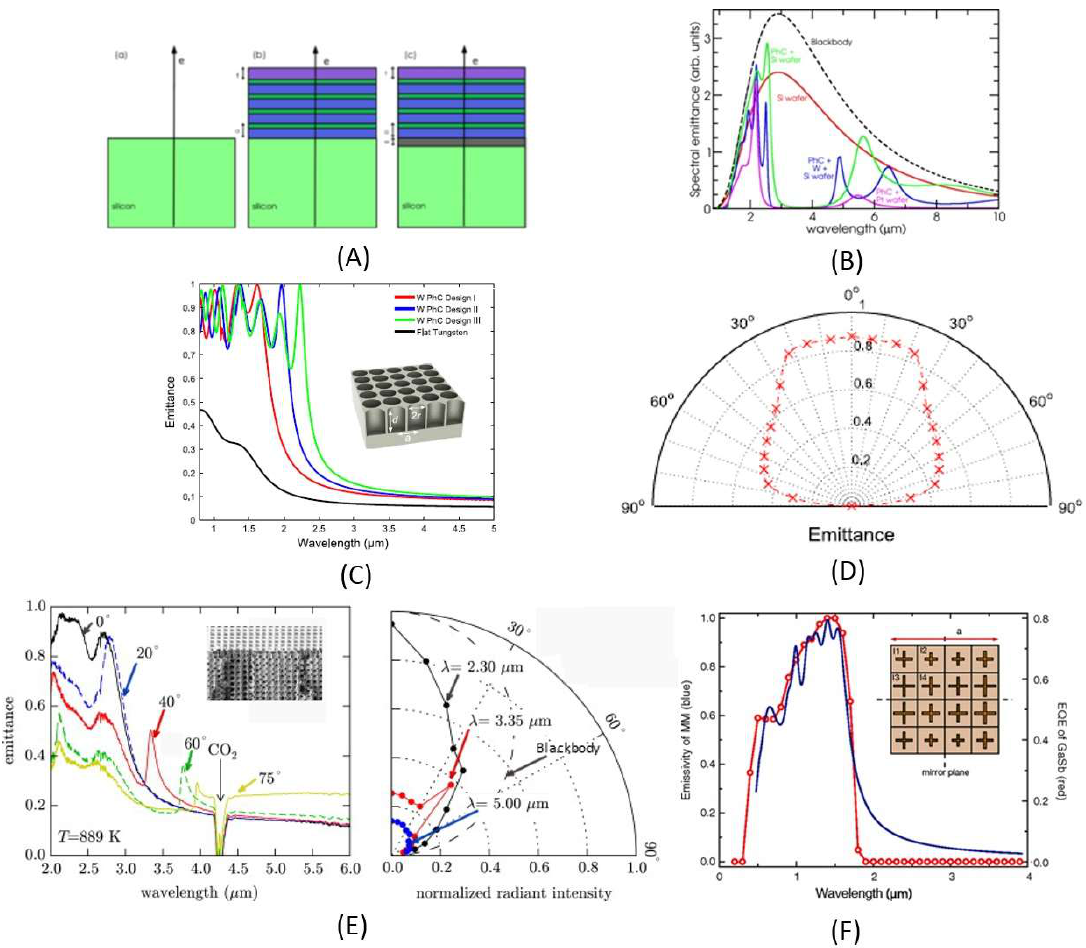
Fig. 8. Photonic crystal and metamaterial emitters. (A) Example of 1D Si/SiO 2 PhC, where an optimized number of layers exhibits the spec- tral emissivity shown in (B). Panels (A) and (B) adapted with permission from [50]. © 2010 Optical Society of America. (C) Simulated normal emittance for W PhC design I ( r = 0.45 µm, a = 1.10 µm, d = 1.50 µm), W PhC design II ( r = 0.55 µm, a = 1.30 µm, d = 2.10 µm), W PhC de- sign III ( r = 0.625 µm, a = 1.40 µm, d = 2.80 µm). Near blackbody performance below the cutoff wavelength is clear compared with flat W [55]. (D) A polar plot of the average emittance below the cutoff wavelength (i.e., λ (cid:54) 2 µm) for W PhC design II [55]. (E) (inset) Scan- ning electron microscope image of the broken side of a 3D Si/Pt PhC [70]. The ALD Pt film covers the full 3D structure. (left) Spectral emit- tance measured for the 3D PhC at 890 K for different exit angles. (right) Normalized radiant intensity polar plot for several wavelengths. The dashed line represents the blackbody curve [70]. (F) Designed metamaterial with wide-band emissivity from [71] (blue curve) and EQE (red curve) of GaSb. Inset shows a schematic of the metamaterial design with 16 sublattices. Panel (F) adapted with permission from [71]. © 2011 The American Physical